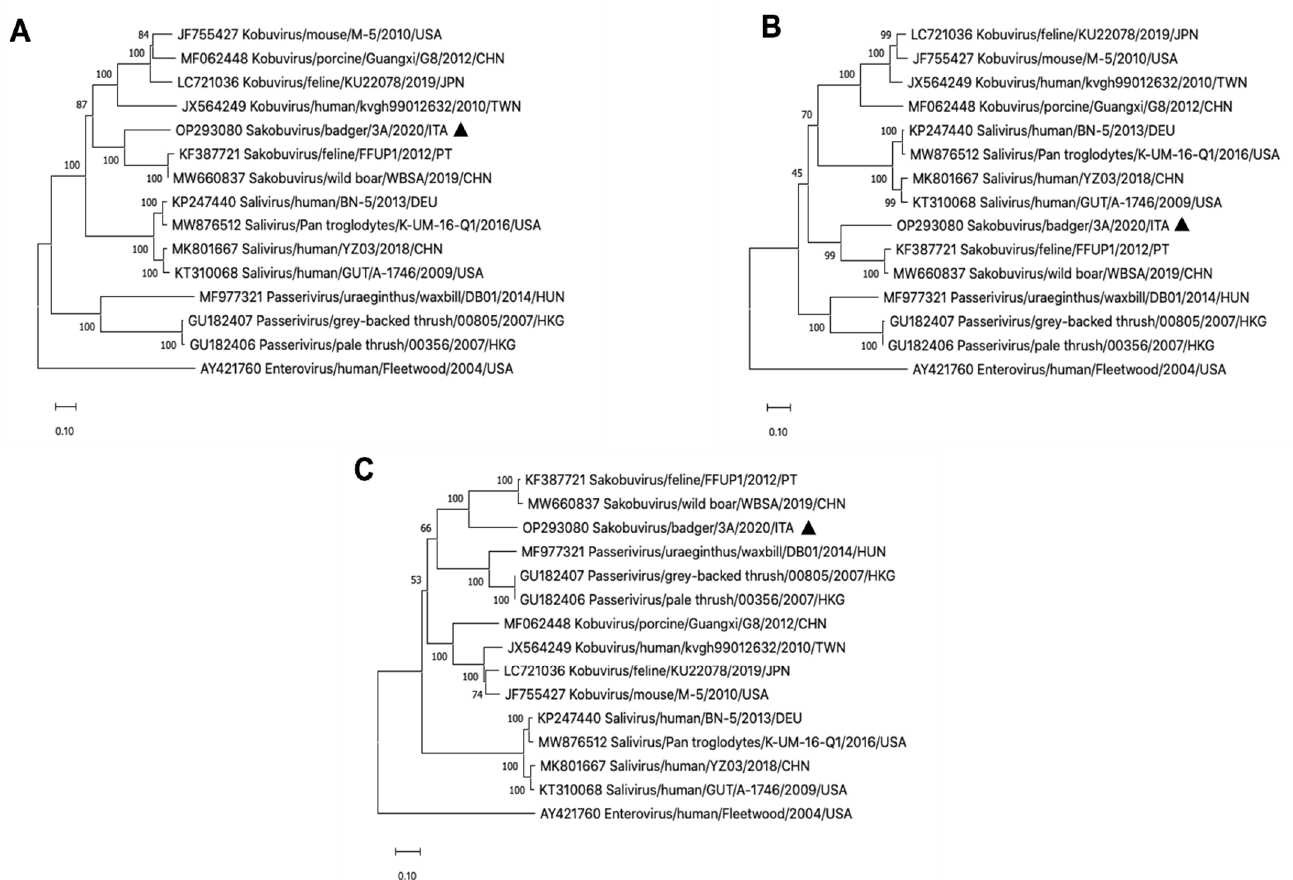
Figure 1. Phylogenetic analyses based on the complete amino acid sequence of the coding regions of P1 ( A ), 2C hel ( B ), 3C pro /3D pol ( C ) of the strain SaKoV/Badger/3A-2019/ITA (GenBank accession no. OP293080). Phylogenetic trees were constructed by using Maximum likelihood method based on the Poisson correction and supplying statistical support with bootstrapping of 1000 replicates. The black triangle indicates the badger strain detected in this study. Evolutionary analyses were conducted in MEGA X [21].